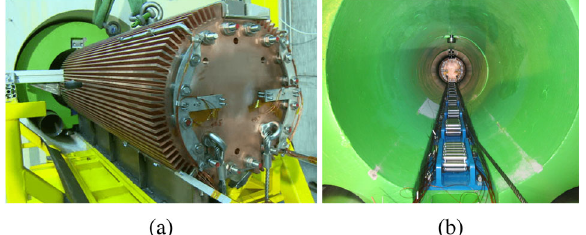
FIG. 20. (a) New CuCr1Zr dump core prior to its insertion in the cavity. (b) The new CuCr1Zr dump core fully inserted in the dump cavity. Visible in blue, the rollers embedded in the shielding blocks that allowed the dump core to be slid to the end of the dump